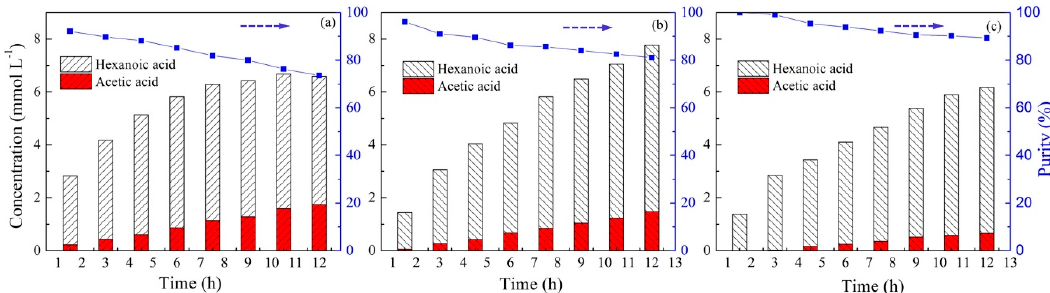
Figure 8. The changes in VFA concentration in the stripping solution with different initial concentrations and the purity of hexanoic acid in the stripping solution (PIMs: PIM4; Feed solution: ( a ) 0.01 mol L − 1 acetic acid + 0.01 mol L − 1 hexanoic acid; ( b ) 0.03 M acetic acid + 0.03 mol L − 1 hexanoic acid; ( c ): 0.05 mol L − 1 acetic acid + 0.05 mol L − 1 hexanoic acid, pH = 6; Stripping solution: 0.1 mol L − 1